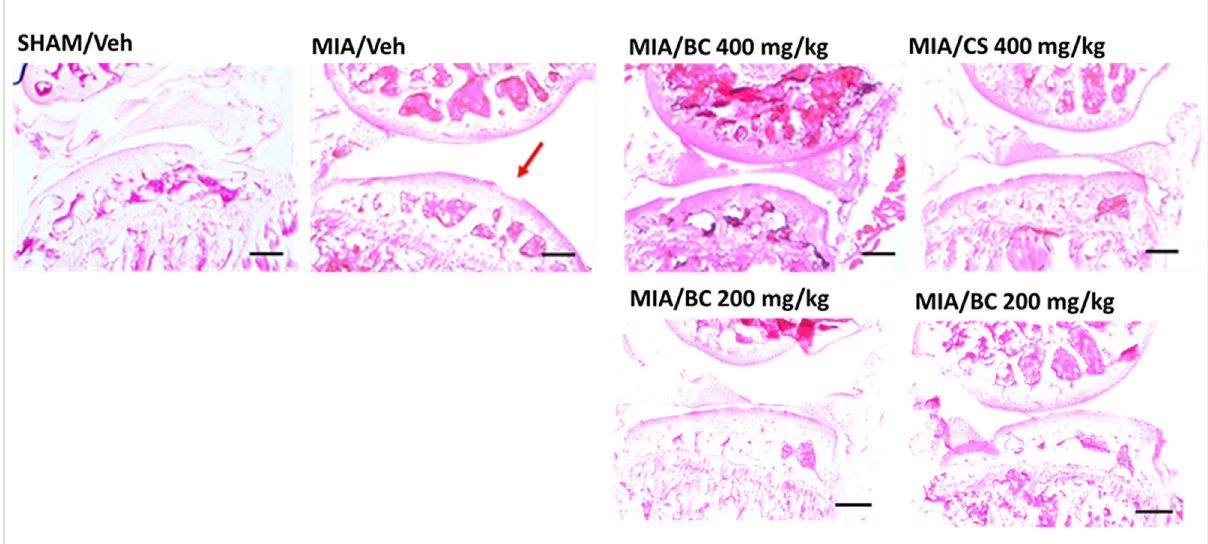
FIGURE 3 HistologicalanalysisofMIA-treated mice.Hematoxylinandeosinstainingoftherepresentativemousejoint( n =3pergroup)ofsham/veh,MIA/ veh, MIA/CS (200 and 400 mg/kg), and MIA/BC (200 and 400 mg/kg) mice. Red arrow shows damaged areas. Scale bar = 40